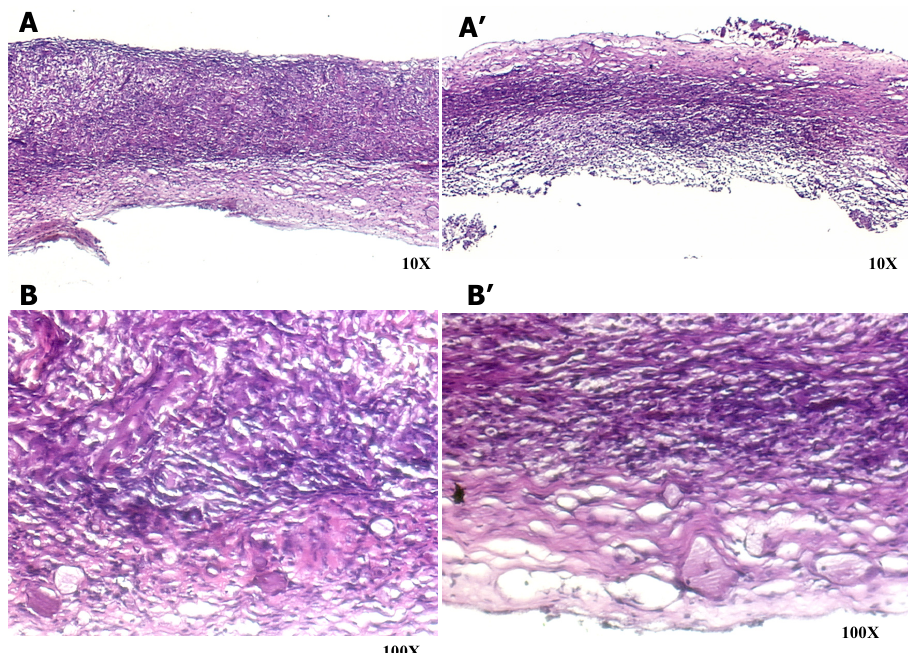
FIGURE 6 - Comparative histological analysis of cranial defects at 8 and 16 weeks postoperatively. A , B : 8 weeks and A’ , B’ : 16 weeks